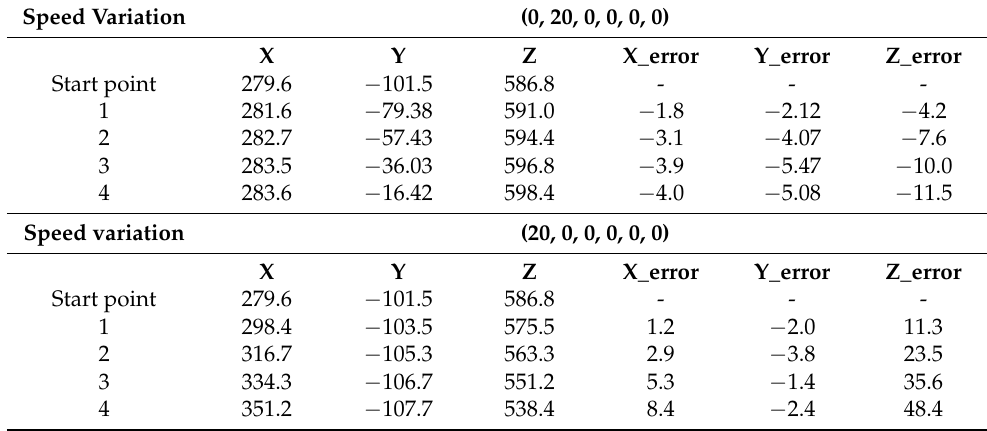
Table 3. Velocity kinematics simulations-Endpoint error of the manipulator posture.